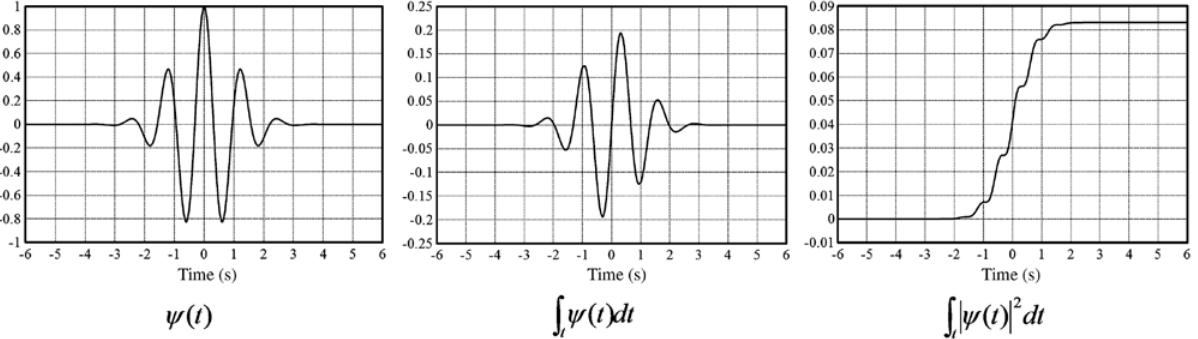
Figure 1: Morlet wavelet time function supplied with regular and square